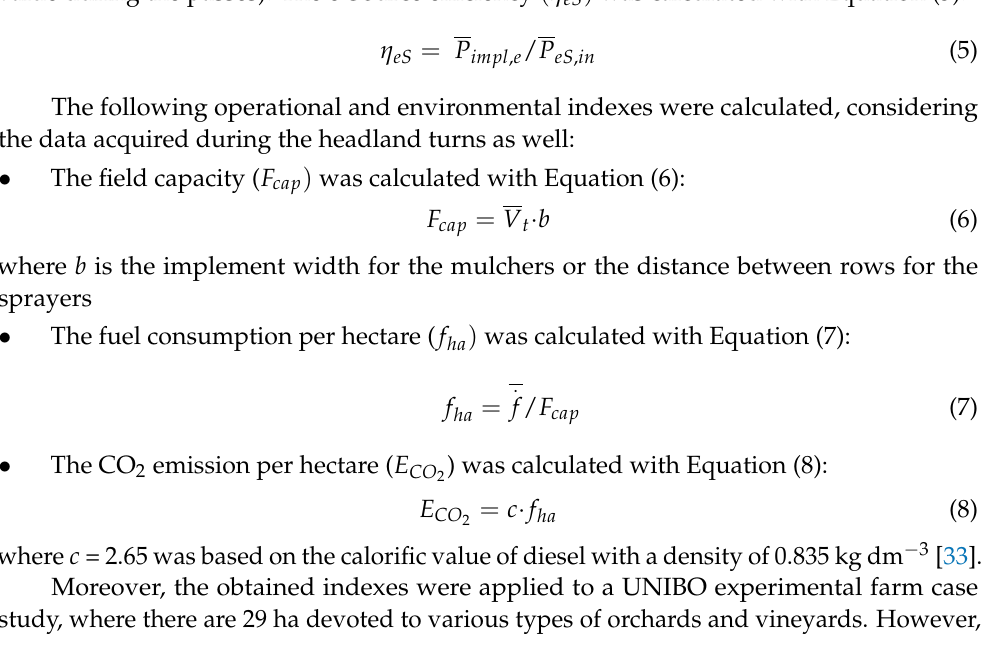
Figure 10. Portion of tractor speed ( 𝑉 (cid:3047) ), and power absorbed by the mSprayer ( 𝑃 (cid:3036)(cid:3040)(cid:3043)(cid:3039),(cid:3032) ) during an acquisition ( a ). Portion of tractor speed ( 𝑉 (cid:3047) ), and power absorbed by the eSprayer ( 𝑃 (cid:3036)(cid:3040)(cid:3043)(cid:3039),(cid:3032) ) during an acquisition ( b ). One can note the effectiveness of the pass selection. The 𝑉 (cid:3047) was mostly constant during headland turns for the large headlands that permitted the ma- chinery to turn with no braking or changing of throttle position. A similar methodology was adopted for both mulchers. After that, the mean values and the standard deviations of 𝑛 (cid:3032)(cid:3041)(cid:3034) , 𝑉 (cid:3047) , 𝑃 (cid:3036)(cid:3040)(cid:3043)(cid:3039),∗ , 𝑃 (cid:3032)(cid:3020),(cid:3036)(cid:3041) , 𝑓(cid:4662) , and 𝑃 (cid:3032)(cid:3020) acquired during the passes were calculated; the average values along passes were denoted with the overbar (i.e., 𝑉 (cid:3047) represents the raw signal, while 𝑉 (cid:3047) represents the